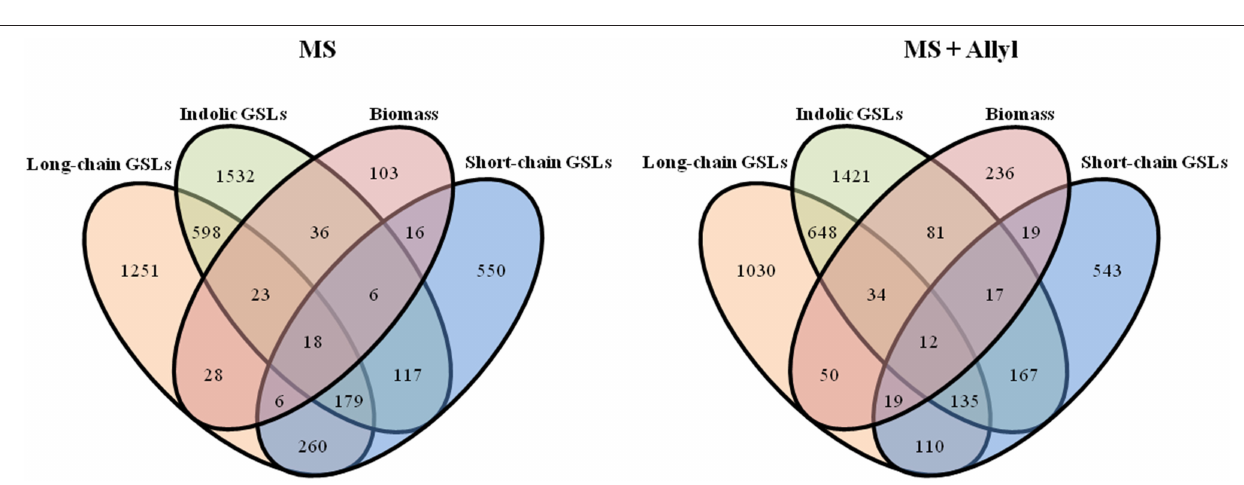
FIGURE 5 | Overlap of significant GWA candidate genes between plant biomass and GSL phenotypes. VENN diagram showing common candidate genes identified among the short-chain GSLs, long-chain GSLs, total incolic GSLs and plant biomass traits studied from control (MS) and treated samples with 50 µ M of allyl GSL (MS +